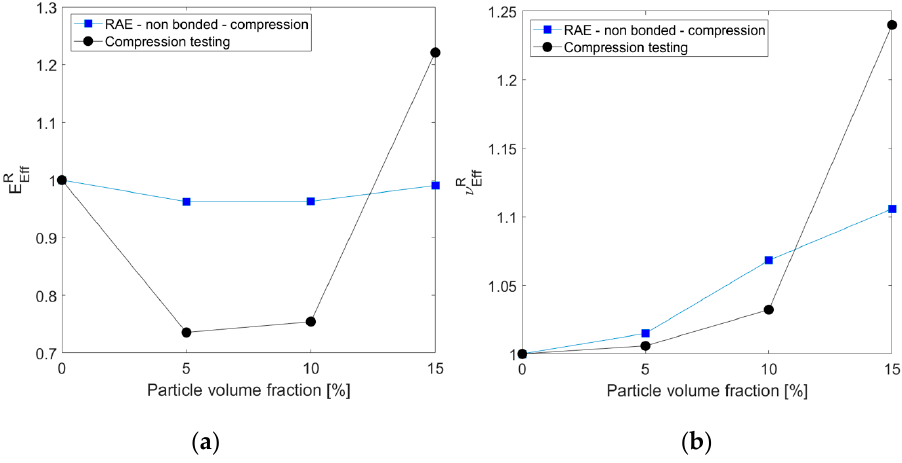
Figure 12. Comparison between measurements (compression testing) and predicted (RAE computations under compression loading) relative effective elastic modulus ( a ) and Poisson’s ratio ( b ) for different particle volume fractions.